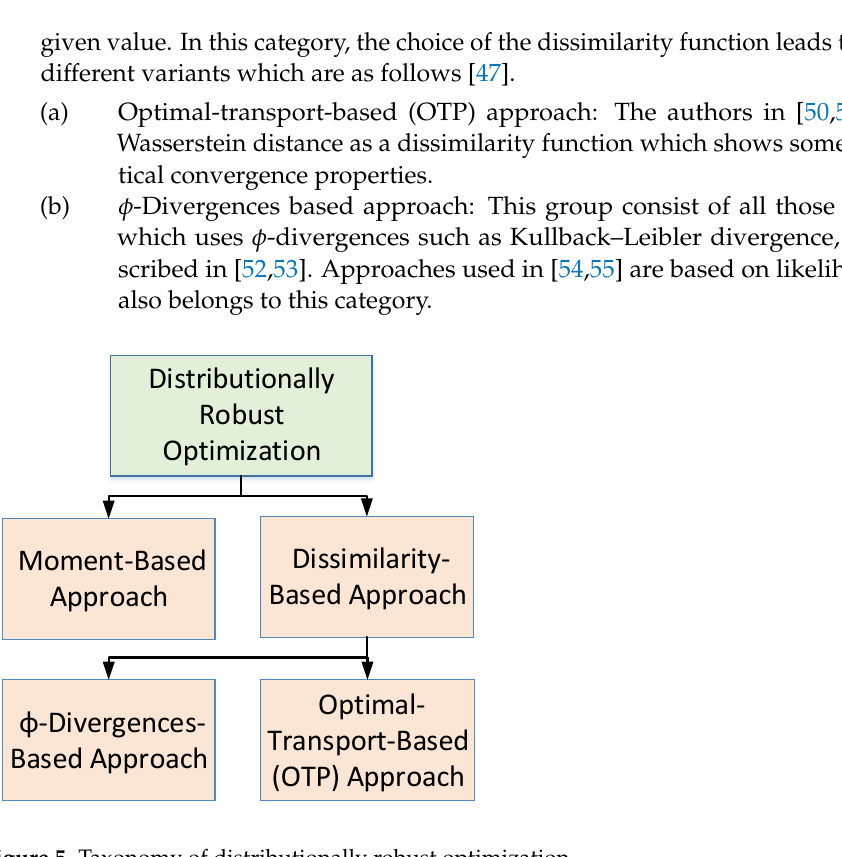
Figure 5. Taxonomy of distributionally robust